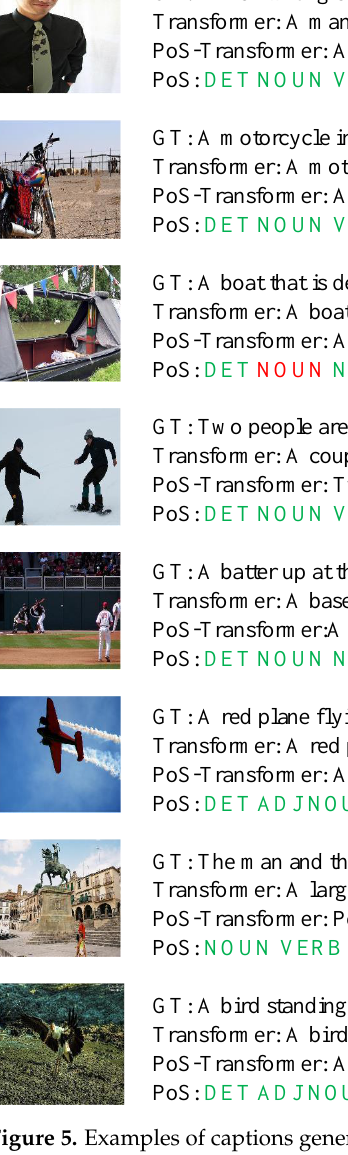
Figure 5. Examples of captions generated by standard Transformer and our proposed model as well as ground truths. Moreover, the PoS sequences generated by our self-attention PoS predictor are also presented. The correct and incorrect PoS tags are colored in green and red, respectively. Generally, our method can generate more accurate and fine-grained